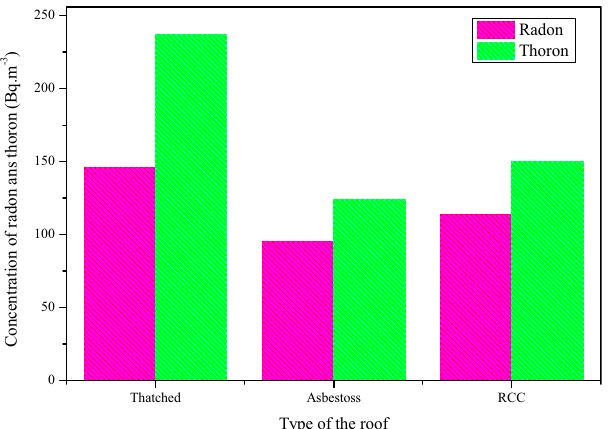
Figure 6. Variation of indoor radon/thoron concentration with different types of materials used for roof.